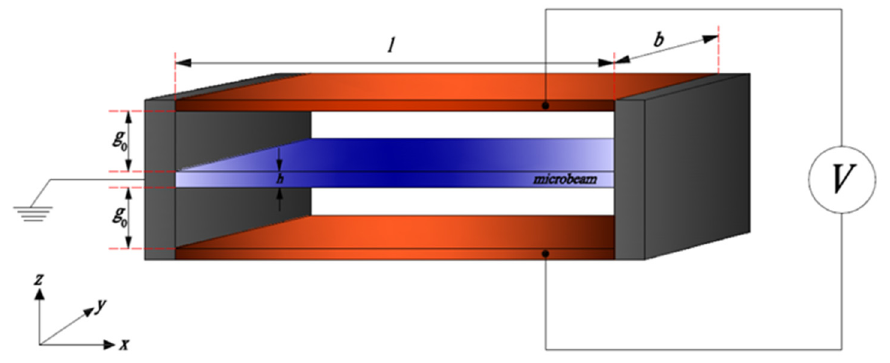
Figure 1. Schematics of a double-sided driven clamped-clamped microbeam-based electromechanical resonator [28].